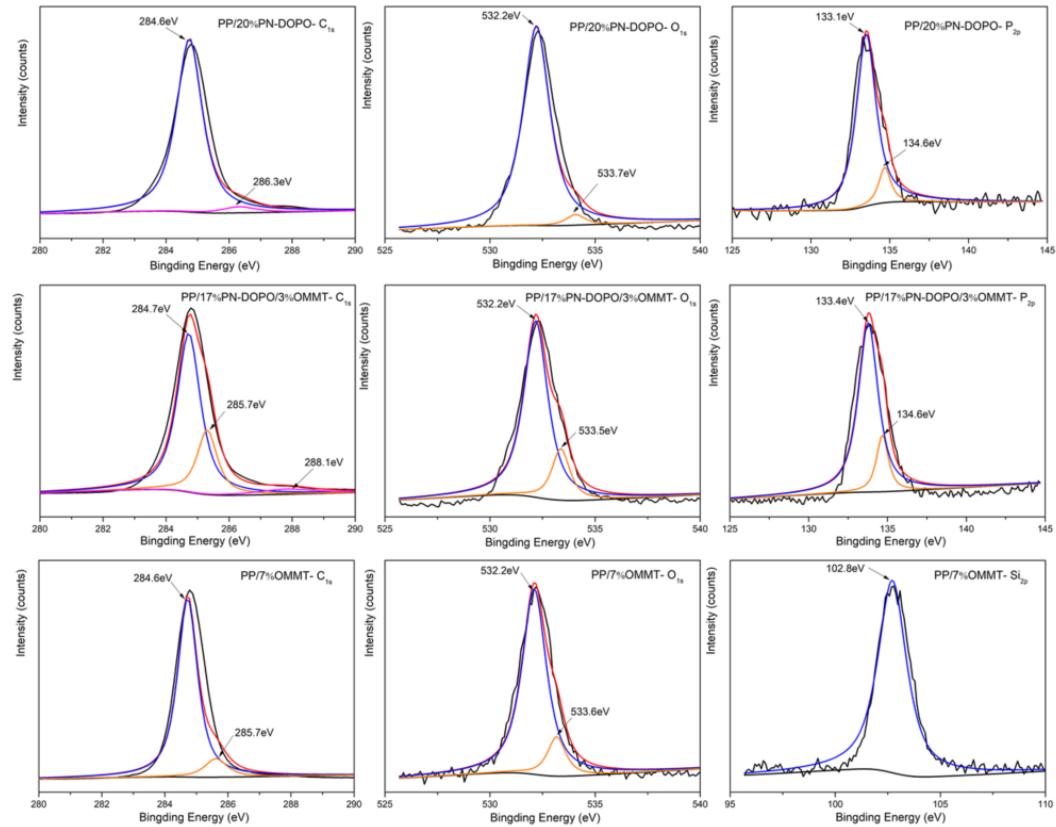
Figure 6. The C 1s , O 1s , P 2p and Si 2p spectra of the char residues of flame-retarded PP composites.